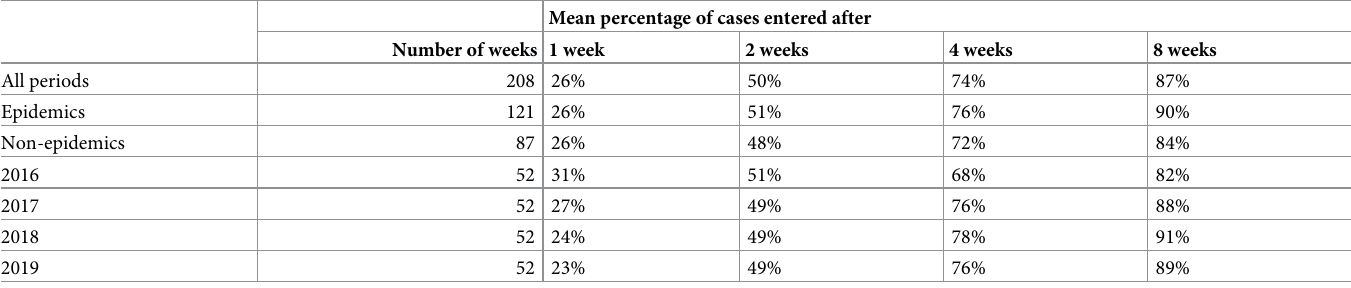
Table 1. Delays between chikungunya case diagnosis and entry into the disease surveillance system. There is often a long delay of weeks or months between initial diag- nosis of a chikungunya case and entry of that case into the monitoring system. Varied delays make nowcasting on a weekly basis more difficult, as we lack complete data on both the most recent week and the weeks shortly preceding it. The first row describes the distribution of delays across the sample as a whole. Only 26% of cases are reported after 1 week, and 74% after 4 weeks. We further find evidence of a tail of cases with very long delays, with 13% of cases still not entered 8 weeks after notification. The second row describes the distribution of delays during epidemic periods, which are weeks in which the case count exceeds 104 cases. This is very similar to the sample as a whole. Similarly, we find that the distribution of delays in non-epidemic periods (third row) and the distributions of delays by year (fourth to seventh rows) do not dif- fer greatly to the distribution of delays for the sample as a whole. This suggests that any differences in the performance of the model in these different time periods are unlikely to be due to differences in the structure of the delays. Mean percentage of cases entered